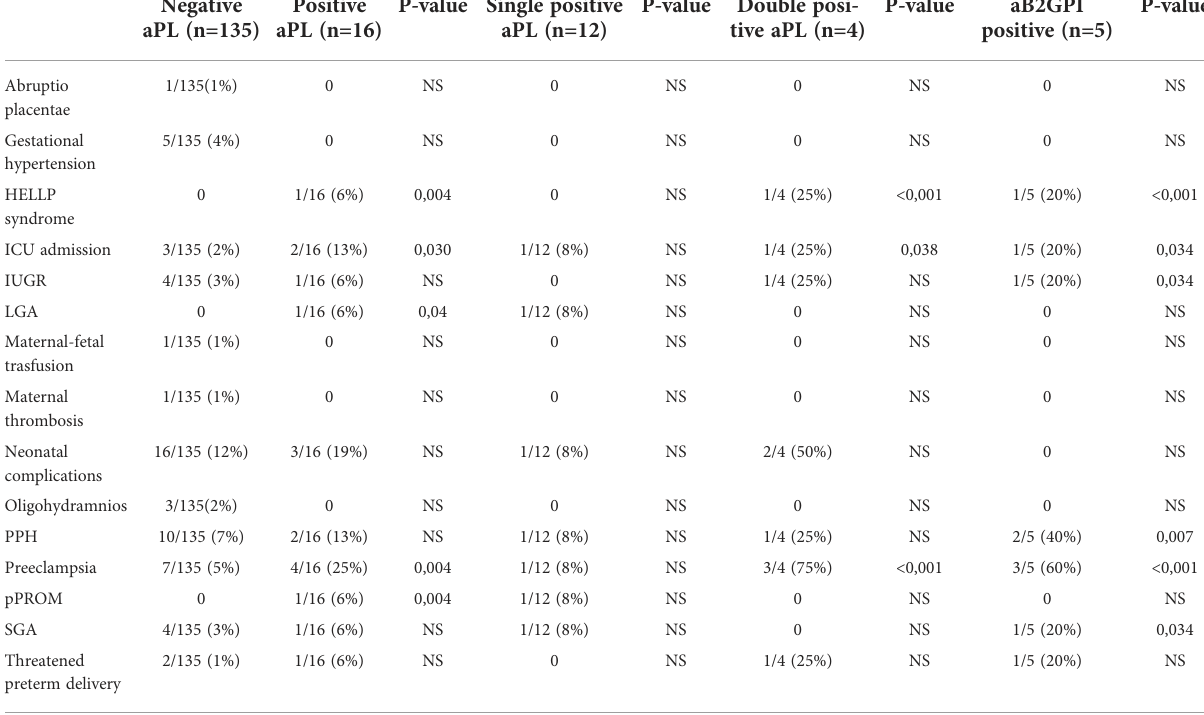
TABLE 2 Pregnancy complications occurring in 151 patients, divided upon pro fi le for antiphospholipid antibodies